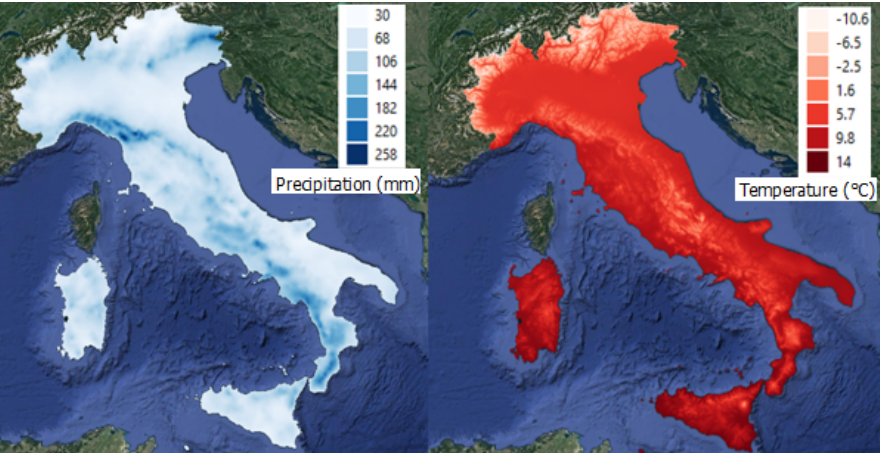
Figure 8. Layer of cumulative precipitation (mm) and temperature (°C) averaged in the winter months (November–April) from ISPRA (the retrieved time window is 1951–2019). The data were available at 1 km spatial resolution and was then re-sampled at the working project resolution (500 m) by means of a bilinear interpolation algorithm.